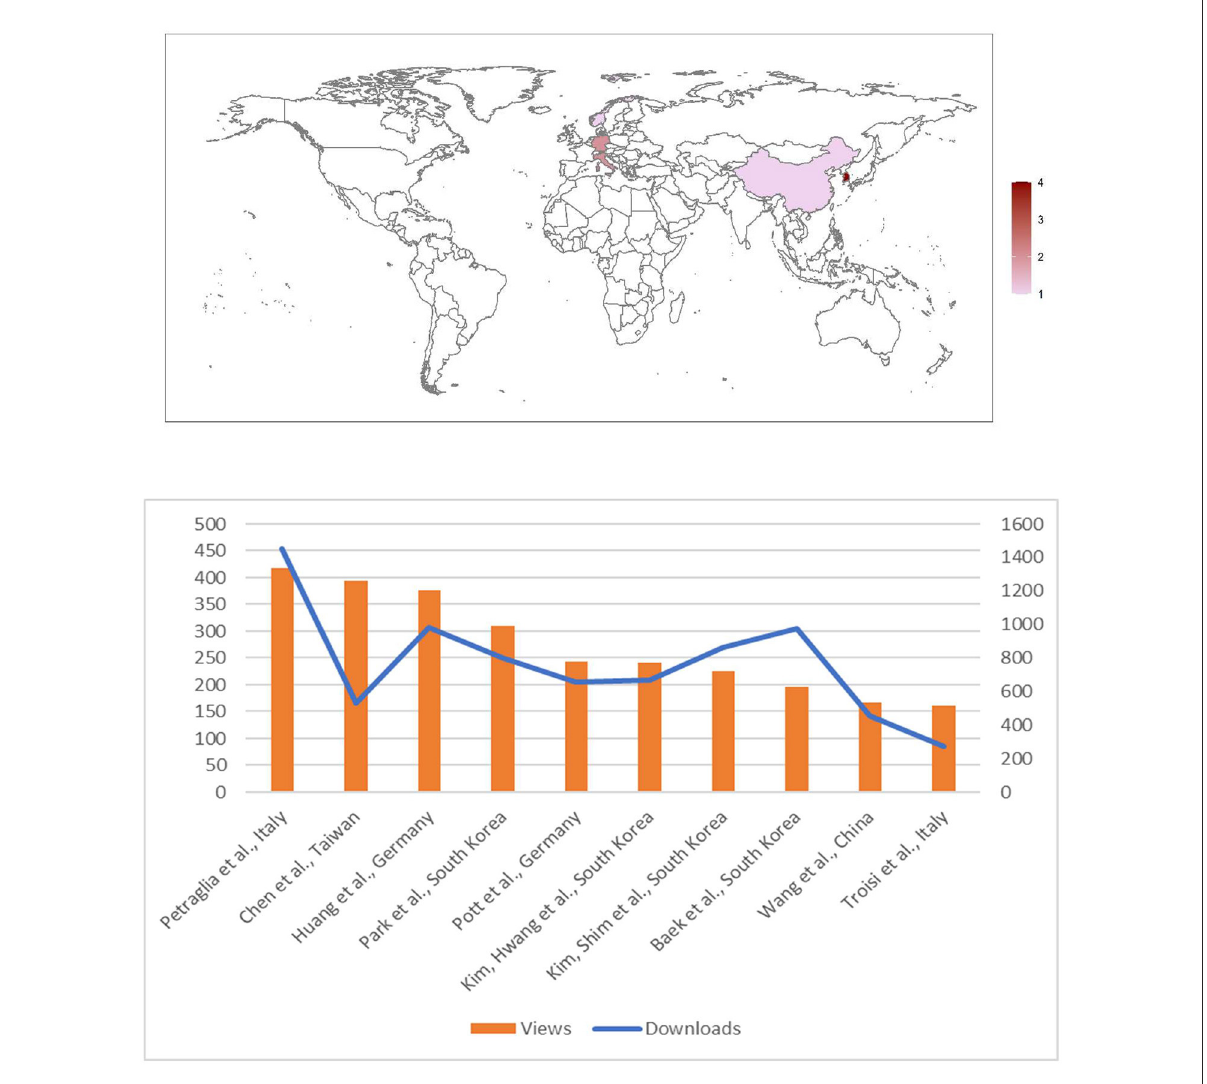
FIGURE1 Metrics (lower panel; update on July 18th, 2022) and number of articles per Country of Authors’ origin (upper panel) of papers published in Frontiers in Cardiovascular Medicine: Insights in cardiac rhythmology